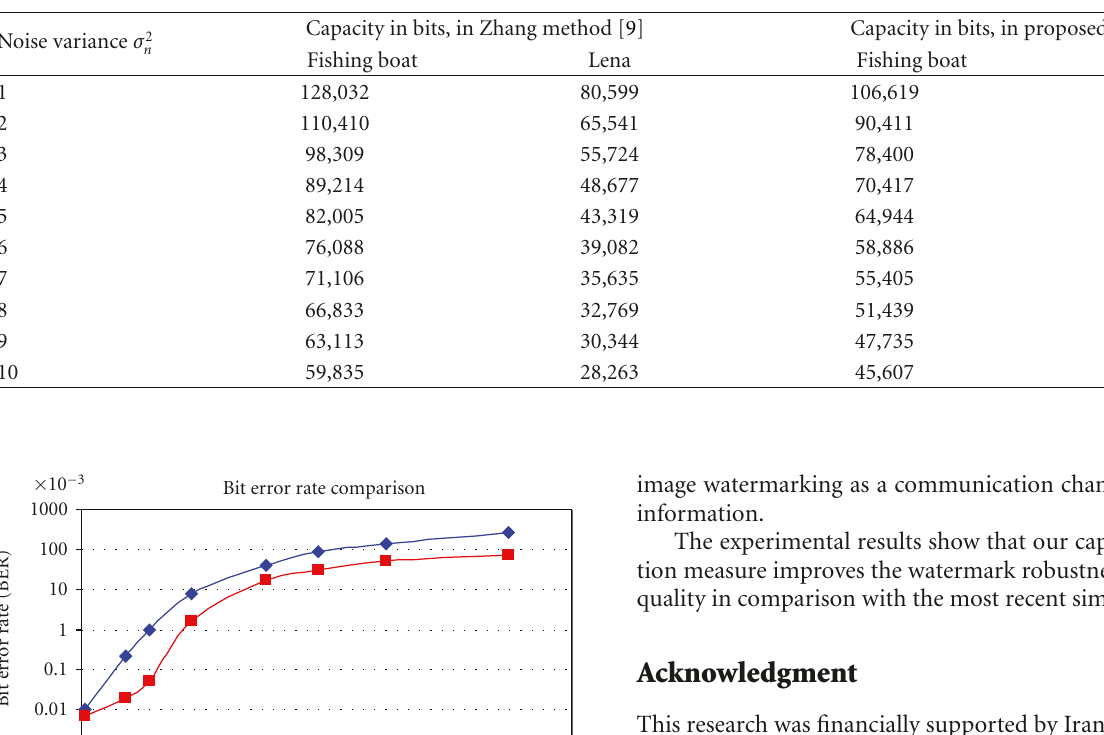
Table 3: Comparison of watermarking capacity estimation in bits (images are 256 × 256).